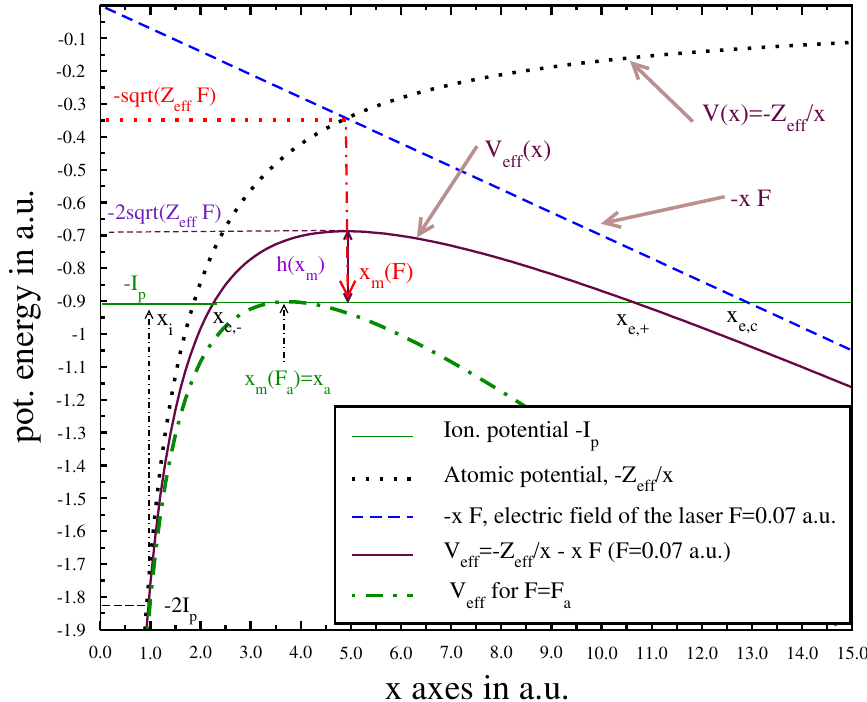
Figure 1. (Color online) Graphic display of the potential and the effective potential curves, the two inner and outer points x e , = ( I p δ z ) /2 F and the barrier width d W = x e , + ± ± and I p is the ionization potential, Z ef f the effective nuclear charge and F the electric field strength of the laser pulse at maximum. x e , c = I p / F d C is the “classical exit” point, x m ( F ) = ≡ the maximum of the barrier height h ( x m ) , x a = x m ( F = F a ) and F a is the atomic field strength; see the text. The plot is for the He atom in the single-active-approximation model with Z ef f = 1.6875 and I p = 0.90357 au. Note, for atoms with different Z ef f and I p , the overall picture does not change.